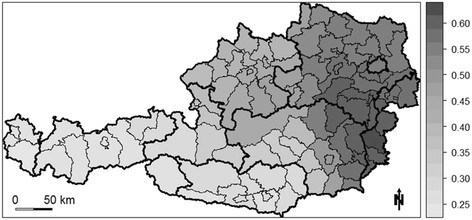
LocalR2values of the GWR model.